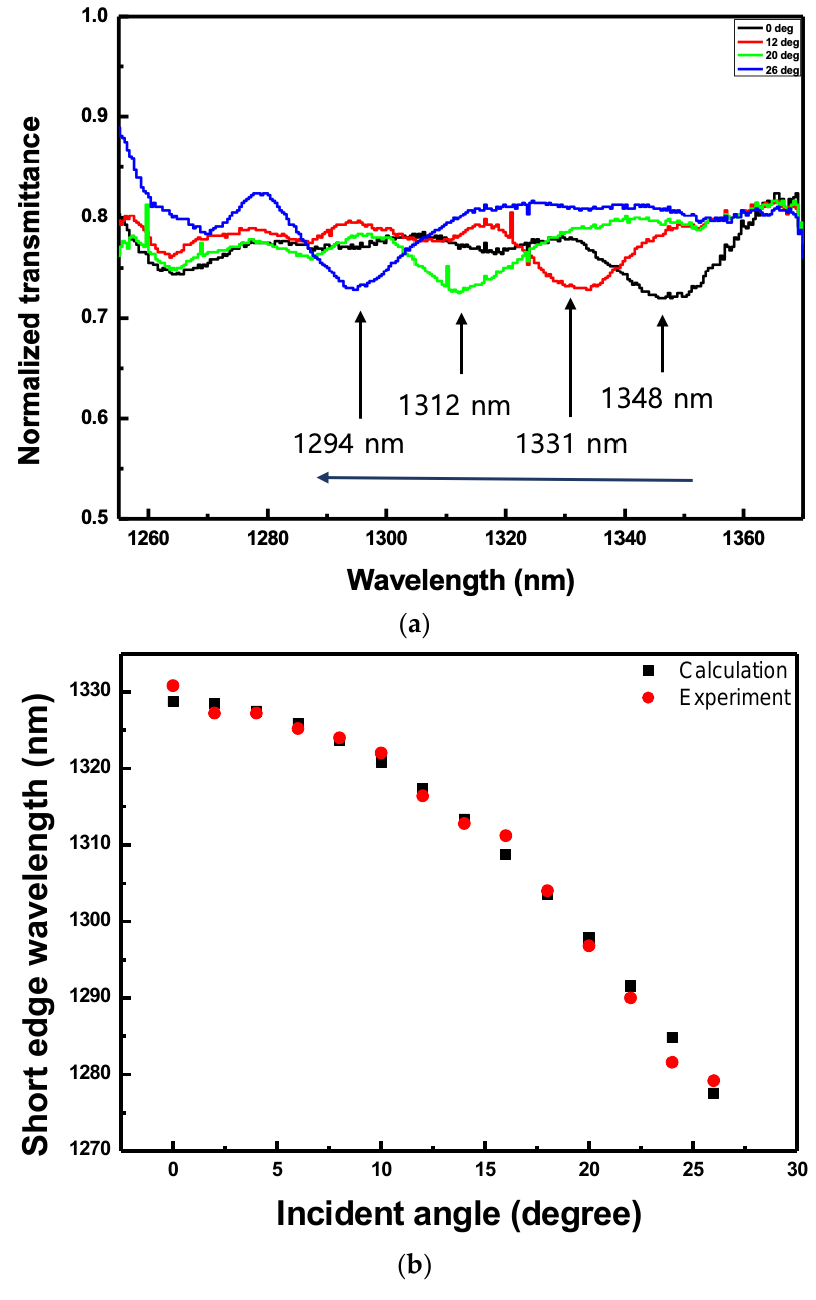
Figure 10. ( a ) Normalized transmitted spectra and ( b ) variation of the short edge wavelength according to the angles of incidence of the beam on the CLC cell when the electric field applied to the CLC cell was fixed to 0.49 V rms /μm.